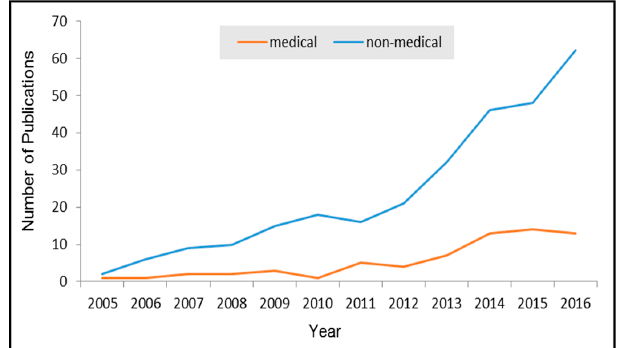
Figure 4. Classification of articles by field and publication year.